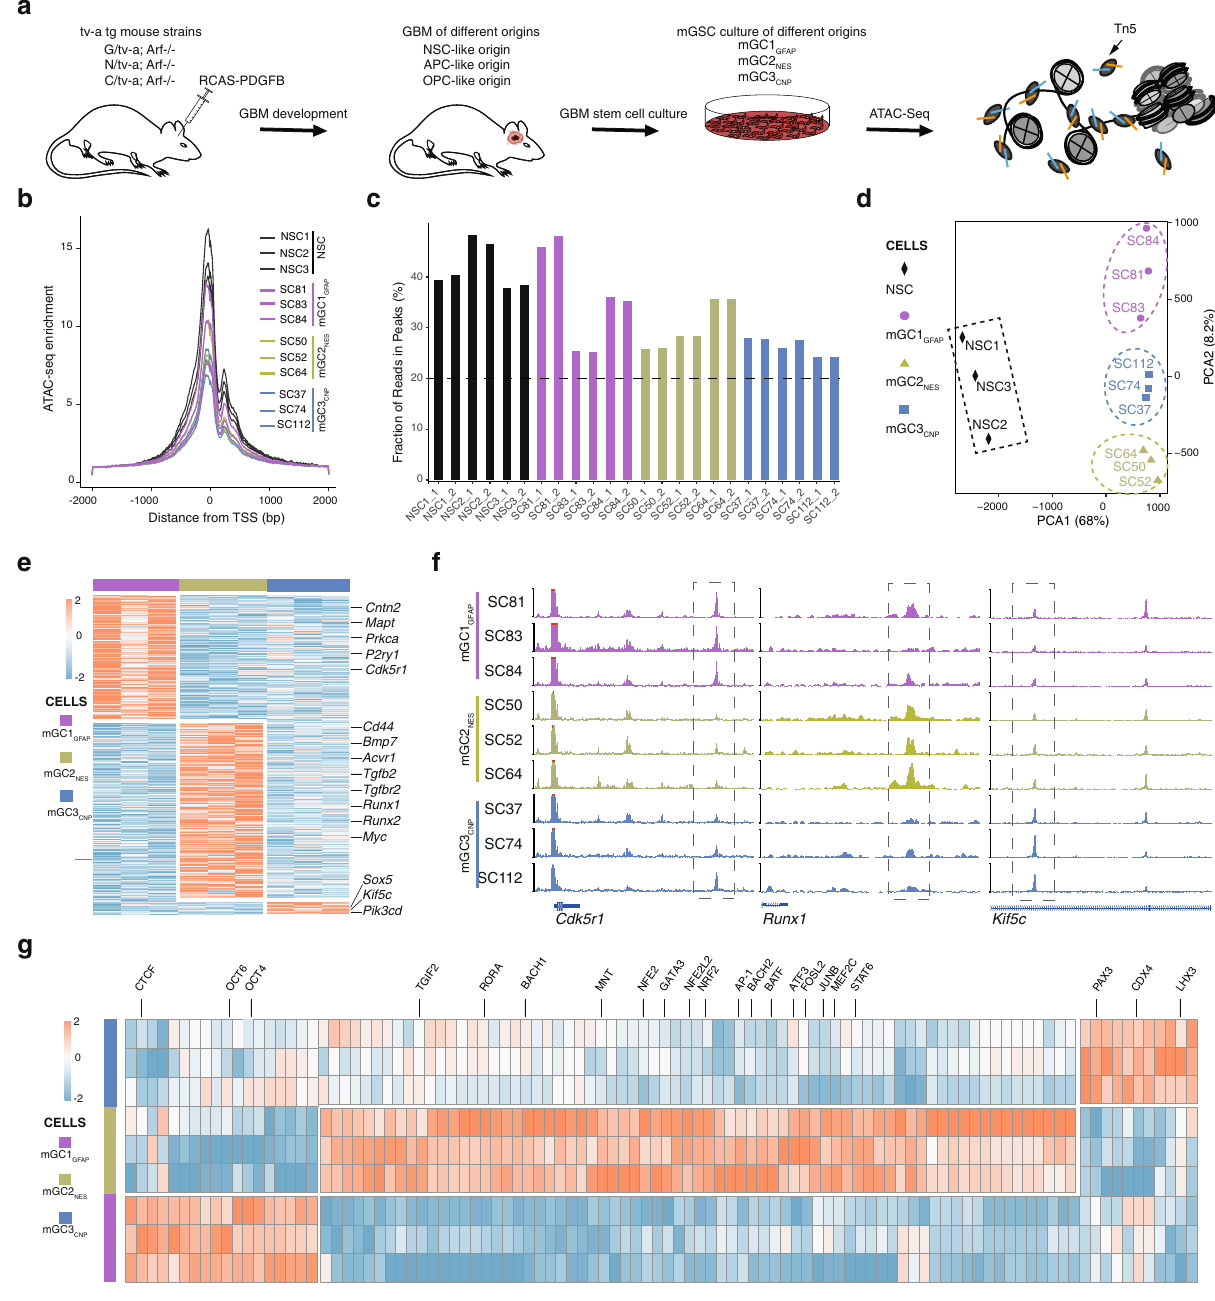
Fig. 1 The chromatin accessibility landscape of mouse GSC cultures can predict cell of origin. a Overview of mouse GBM models and GSC cultures of different origin that were analyzed by ATAC-seq. Schematic fi gures were produced by the authors. b Enrichment of ATAC-seq reads at transcription start sites (TSS) from the mGSC cultures. c Fraction of reads in peaks (FRiP) in duplicate samples of mouse NSC and GSC cultures. Dashed line shows minimum FRiP score required for further analyses of that sample. d Principal component analysis of ATAC-seq data from mouse NSC and GSCs samples. Dashed ovals show same origin mGSC samples. Dashed square show control NSC samples. e Heatmap of unique accessible chromatin regions of each mGSC cell of the origin group. Examples of genes annotated to the chromatin regions are indicated. f Genome browser tracks of ATAC-seq data for each mGSC sample of Cdk5r1 , Runx1, and Kif5c . g Heatmap of mGSC group-unique, signi fi cantly enriched TF motifs. Examples of TFs are indicated. Source data are provided as a Source Data fi le for Fig. 1b – e,